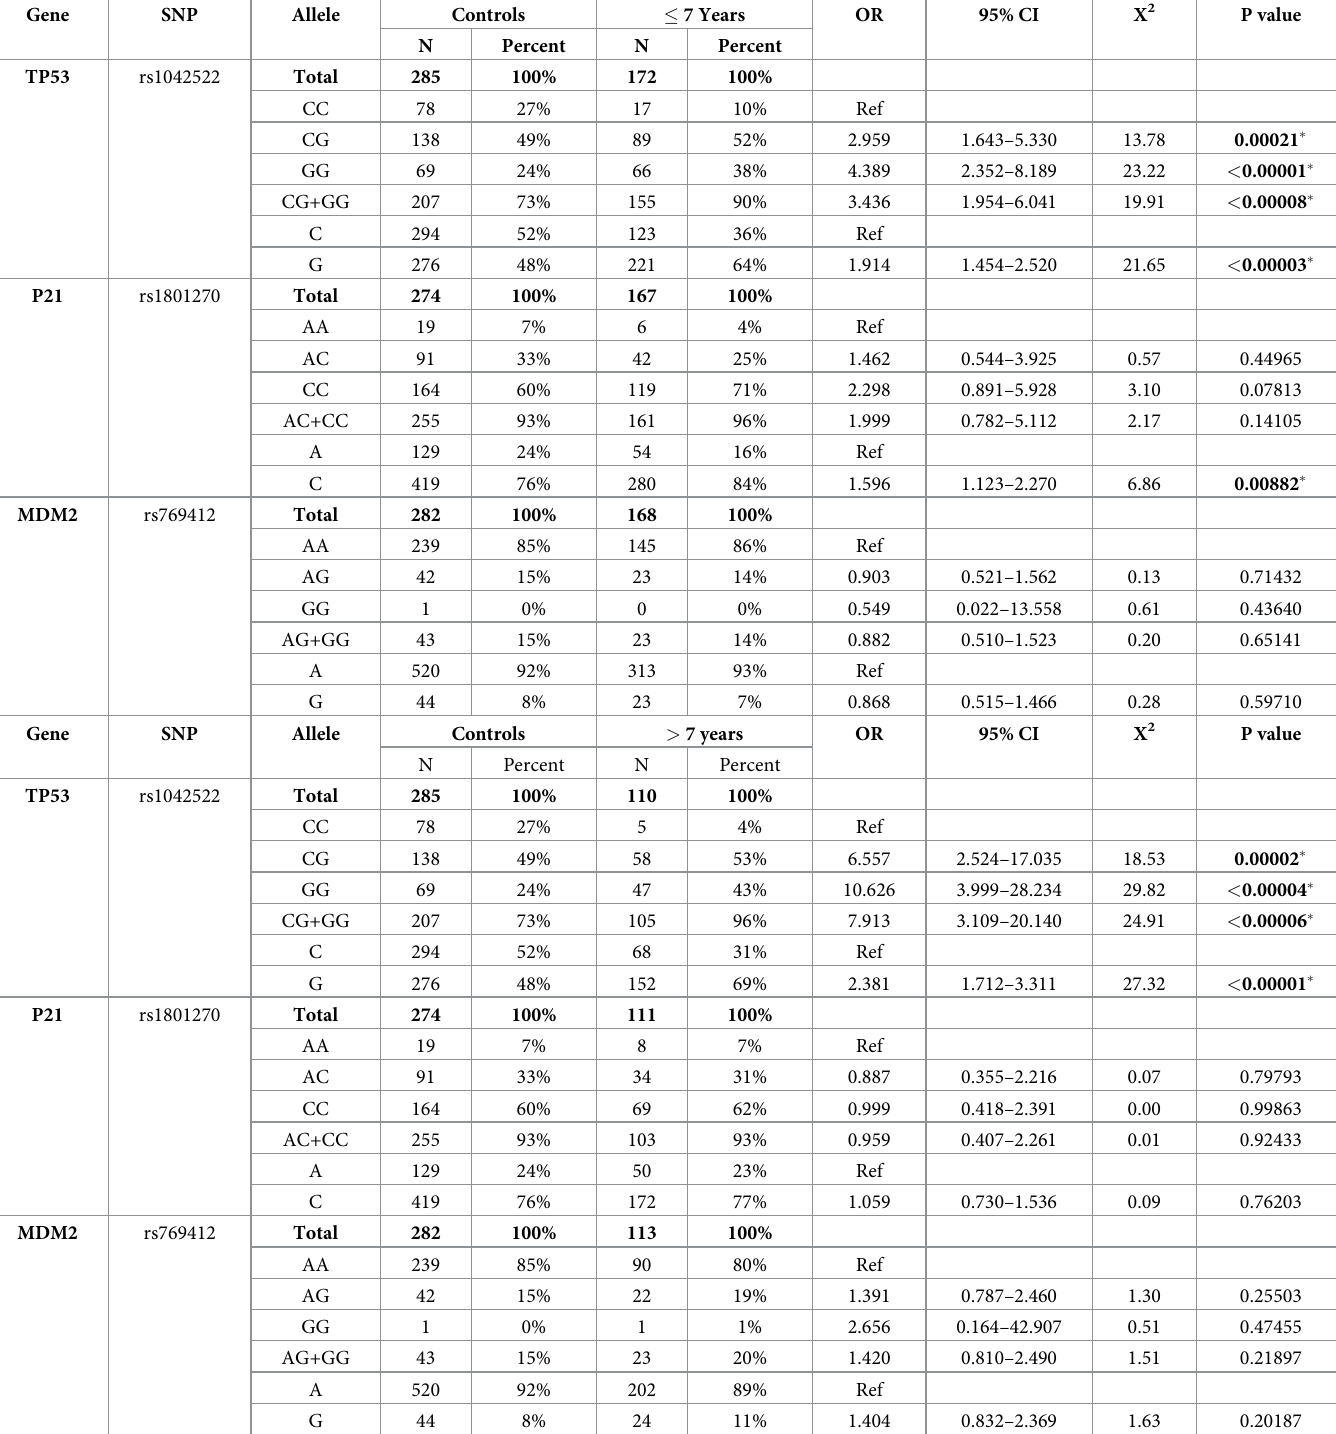
Table 6. Genotype frequencies of P53, P21, and MDM2 gene SNPs in smokers smoking for � 7 years and > 7 years and in their controls. Gene SNP Allele TP53